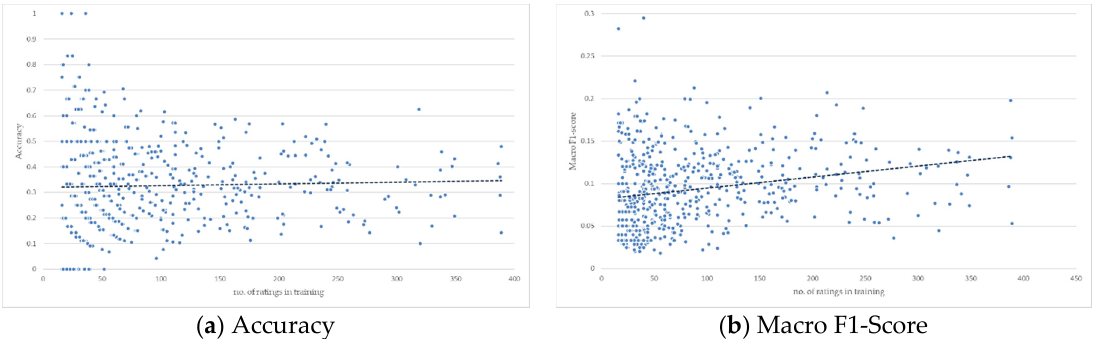
Figure 24. Change in measured values according to the number of ratings in training (Exp. 2).